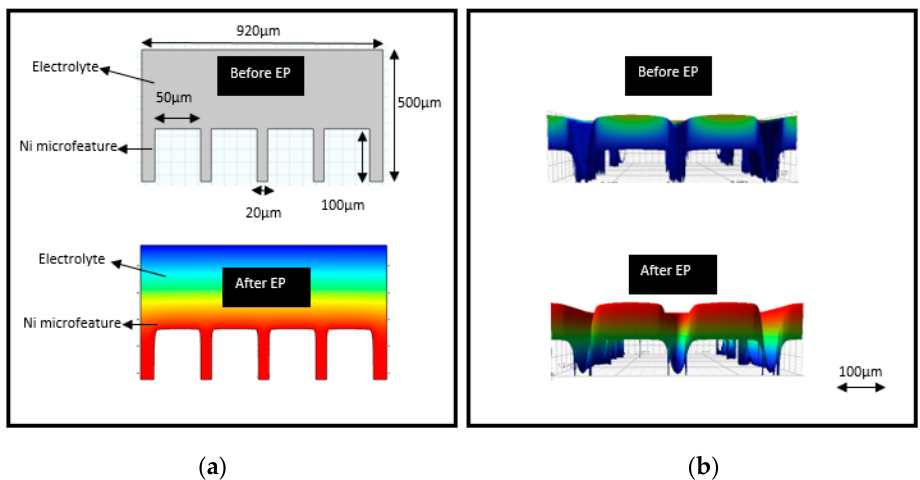
Figure 27. Electropolishing for shaping of micro-scale features.